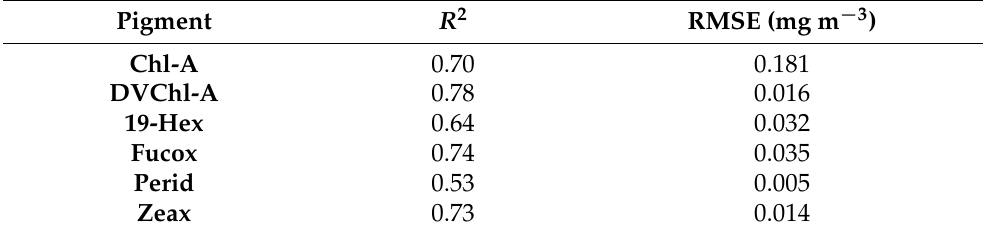
Table 2. Validation results for the completion of the data by